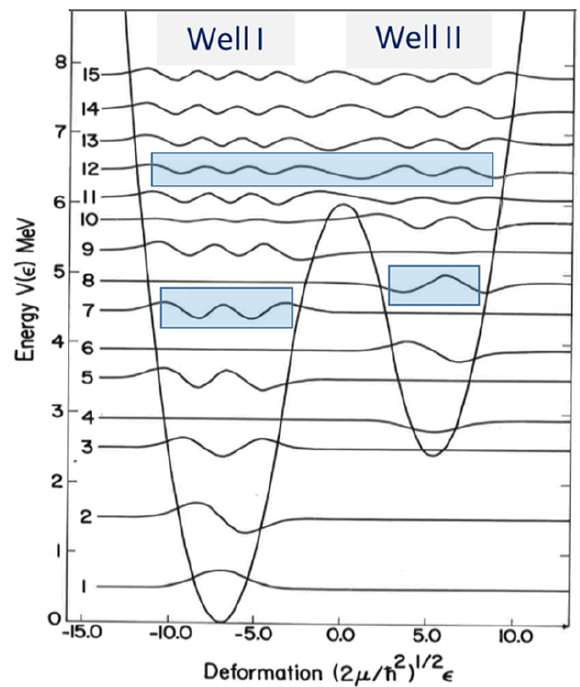
Figure 5. Illustration of  -vibrational states in a two-well po- tential composed of three smoothly joined parabolas. Note the fission isomer located in the second well (state #4) and the mix- ing of Well I and Well II states occurring near and above the intermediate barrier. [B. B. Back, (1972) unpublished].